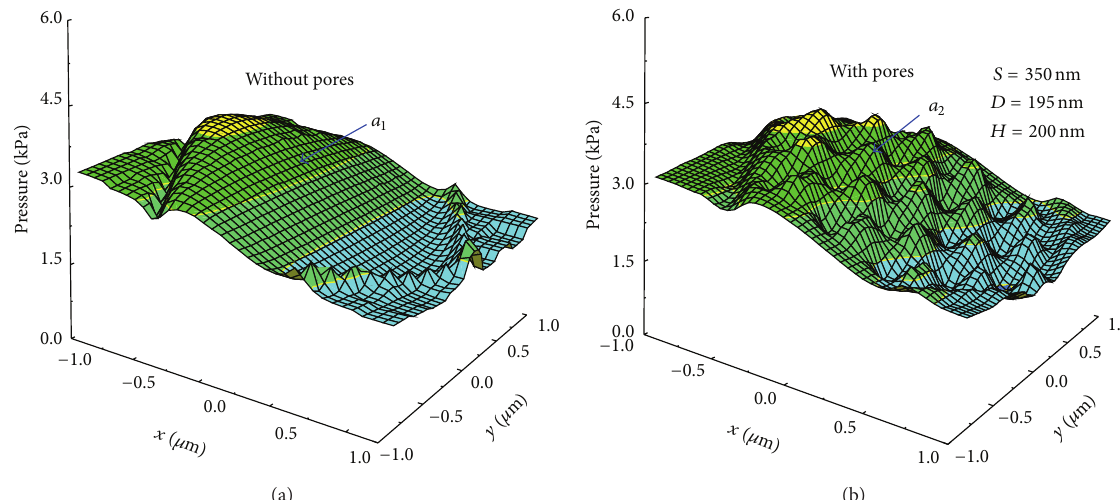
Figure 4: Pressures of Coscinodiscus sp. frustule with and without pores: (a) without pores and (b) with pores.